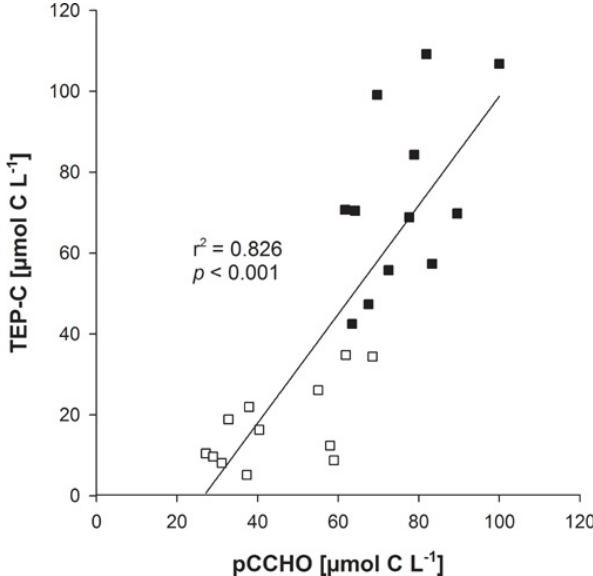
Fig. 5. Correlation between the concentration of particulate com- bined carbohydrates (pCCHO) and the carbon content of transpar- ent exopolymer particles (TEP-C) (Pearson Product Moment Cor- relation; n = 24, r 2 = 0 . 826, p < 0 . 001). Open and closed symbols represent data obtained at µ = 0 . 3d − 1 and µ = 0 . 1d − 1 , respec- tively.